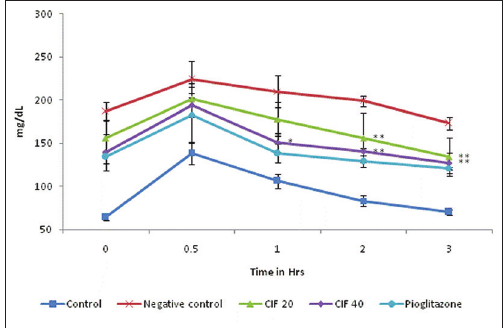
FIGURE 3. Effect on oral glucose tolerance test after 12 th week of STZ administration in rats pretreated with CIF (n=10). Blood glucose levels of CIF 20, 40 and pioglitazone treatments were compared with that of negative control group at respective time intervals. * p<0.05, ** p<0.01. TABLE 1. Effect of CIF on blood glucose levels in rats pretreated from 4 th week after STZ administration Treatment Blood glucose levels (mg/dL) at various intervals (days) after 12 th